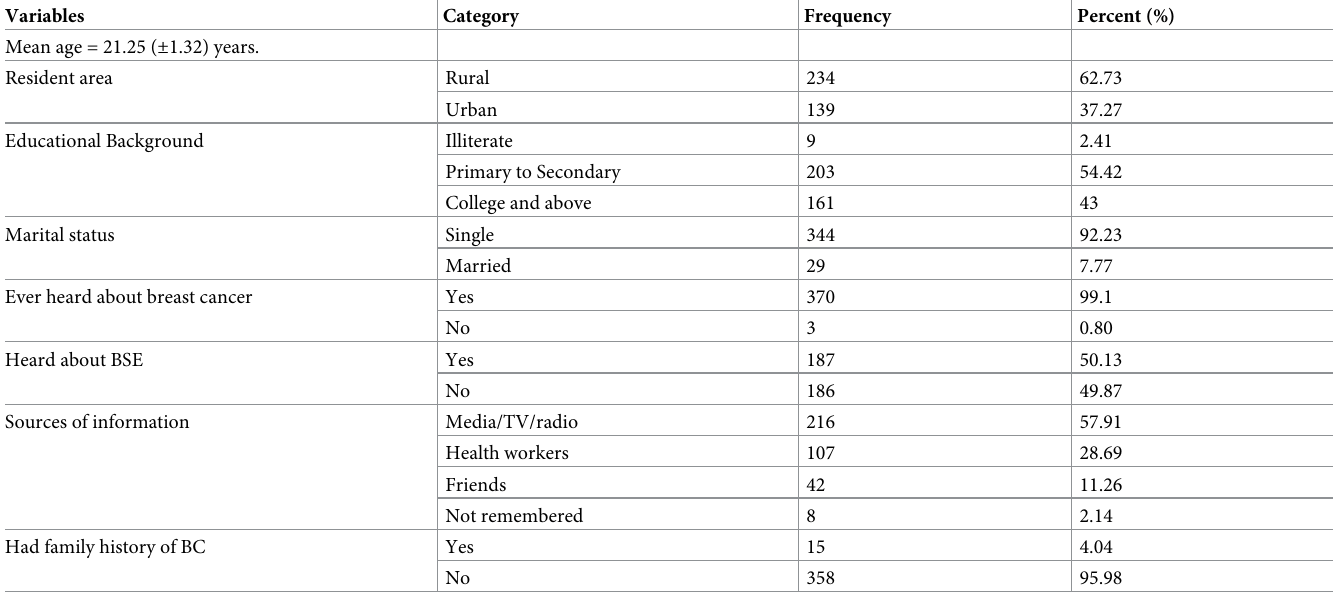
Table 1. Socio-demographic profile of young adult women Gurage